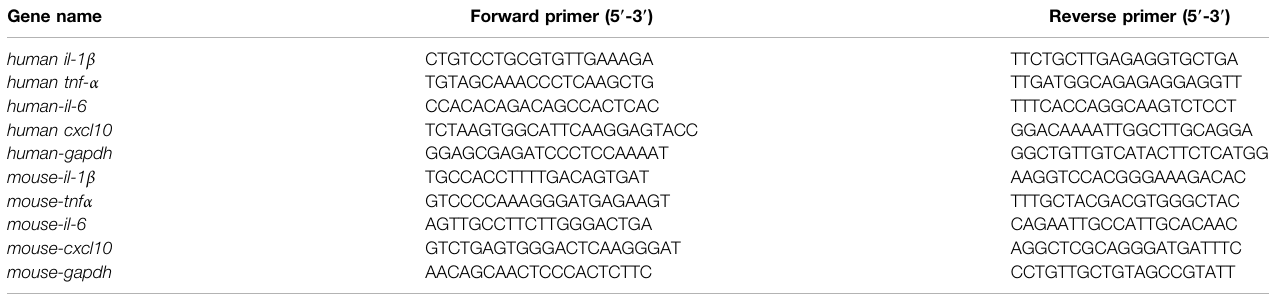
TABLE 1 | The primers used for RT-PCR.